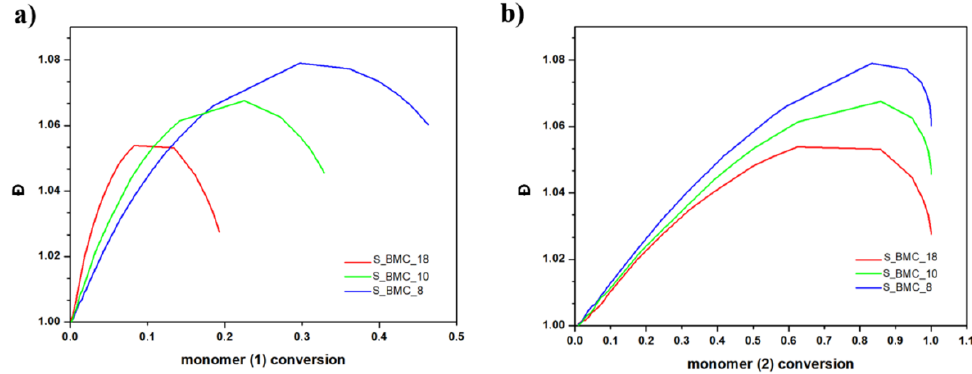
Figure 14. DLL simulation of dispersity index (Đ) with conversion of ( a ) (1) monomer and ( b ) (2) monomer.